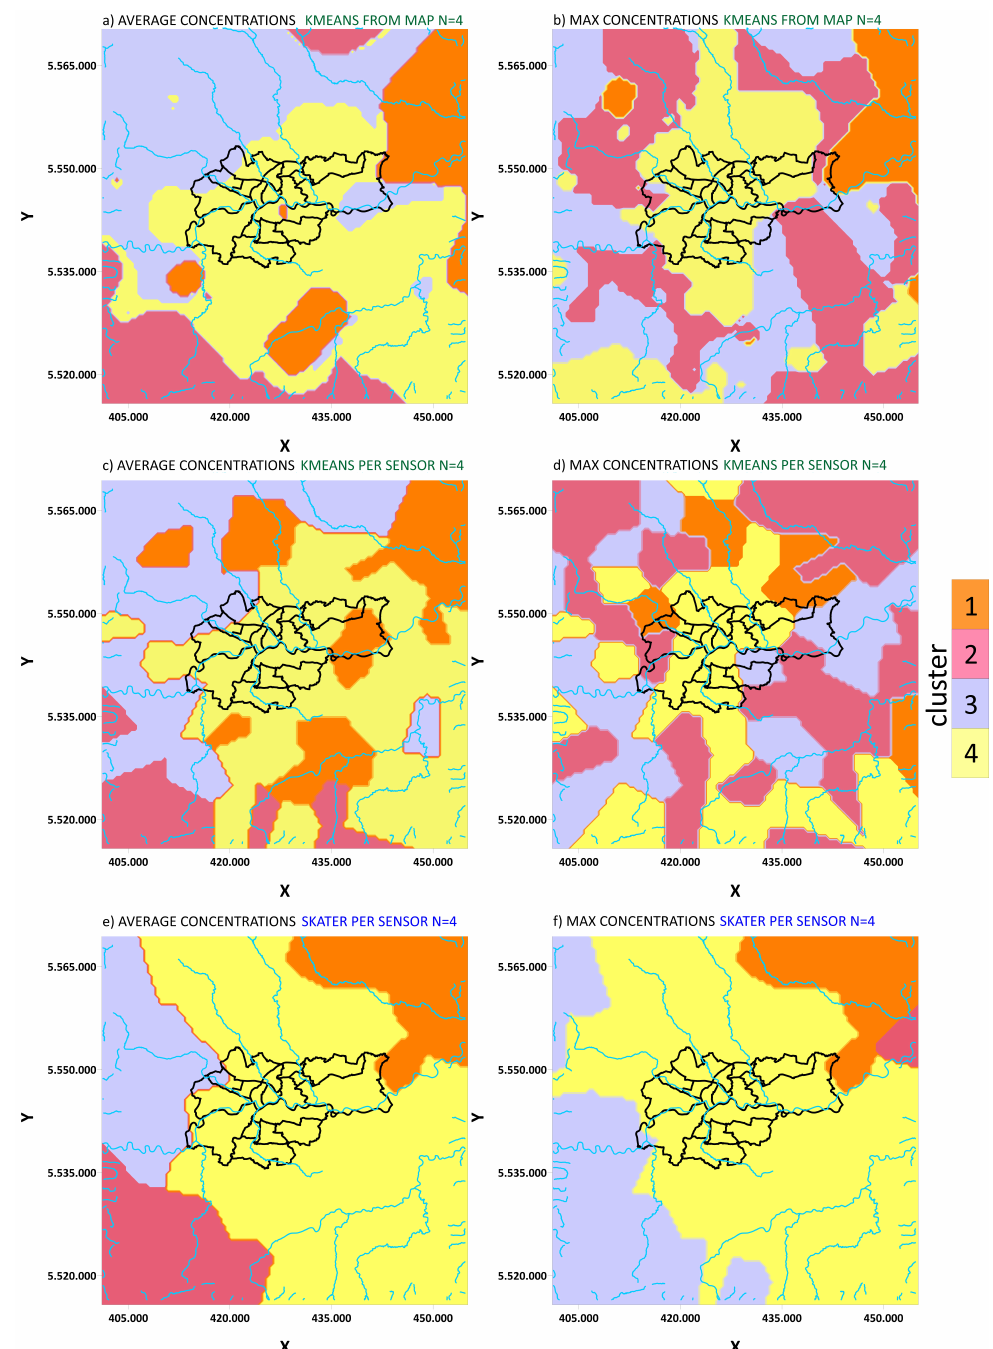
Figure 8. Clustering results for K-means with DTW and SKATER algorithms for maximum and average concentration in 12-month